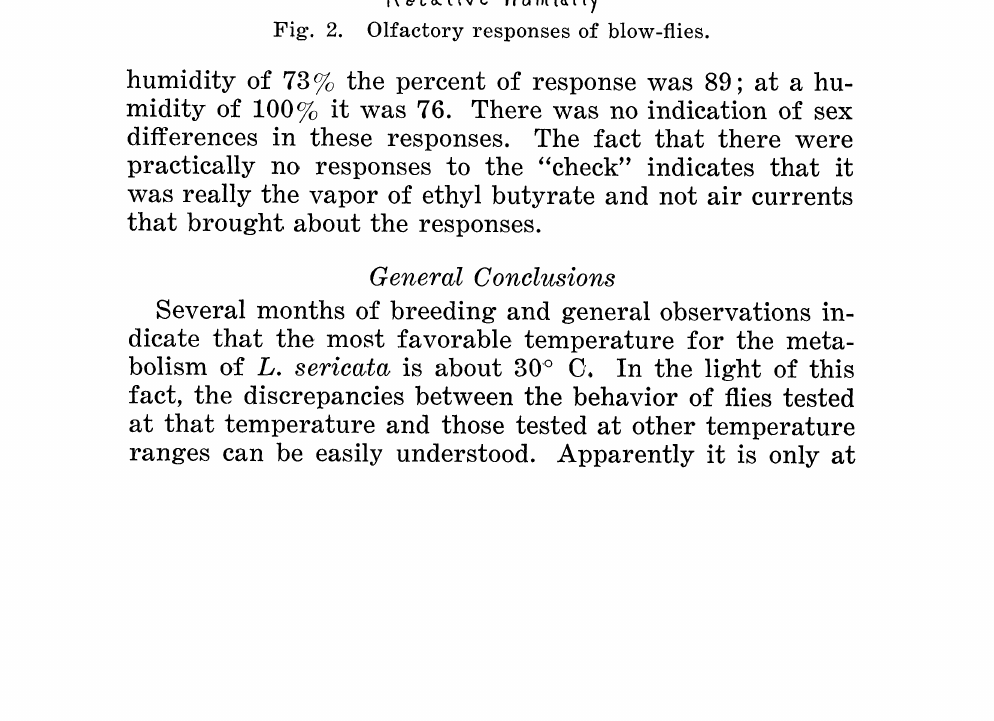
Fig. 2. 01aetory repoe o